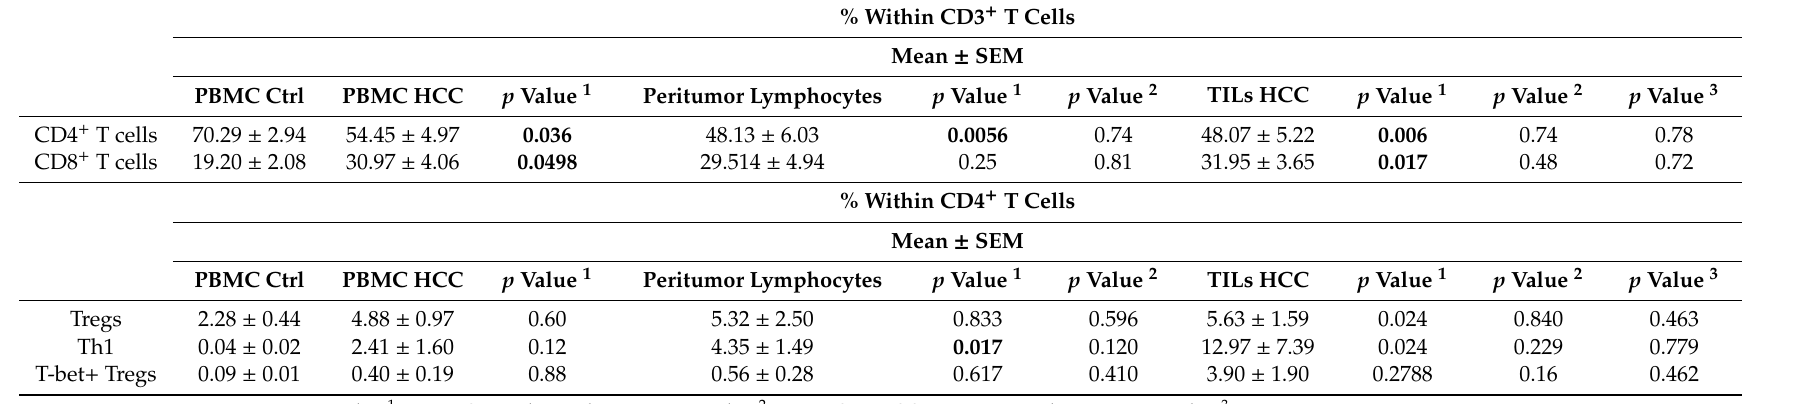
Table 3. CD4 + and CD8 + T cell subsets.